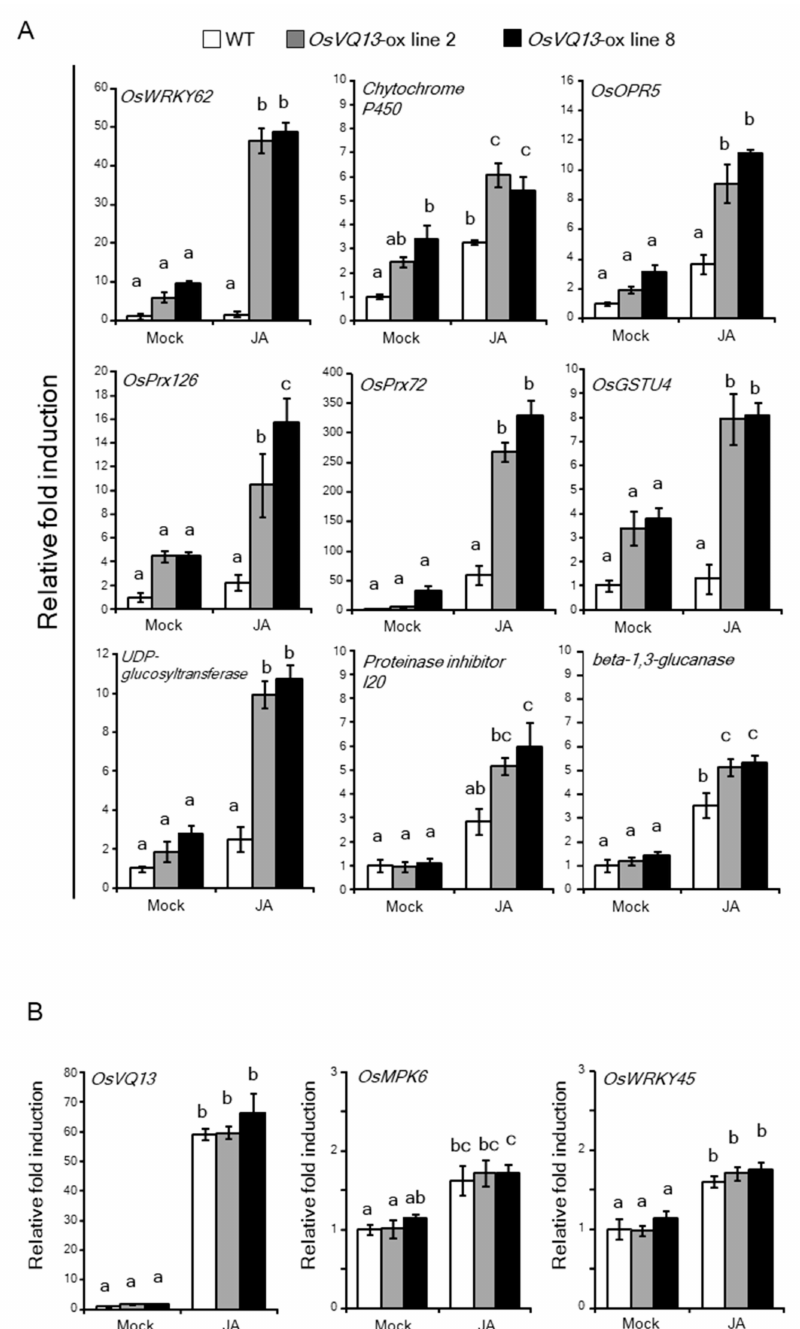
Figure 5. Expression of OsWRKY45-responsive defense-related genes in OsVQ13 -overexpressing rice